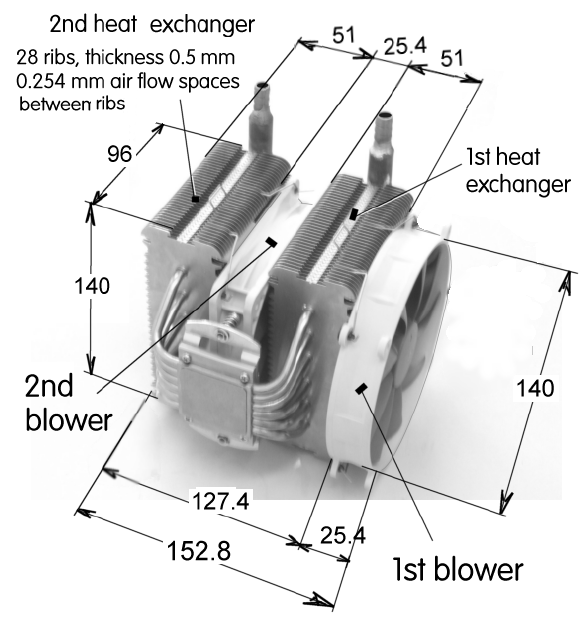
Fig. 21. The unit used to drive the circulating heated air in the wind tunnel by the two blowers - and also maintaining its temperature by means of the two-component heat exchangers. Liquid with precisely adjusted temperature is supplied from an external thermostat unit.